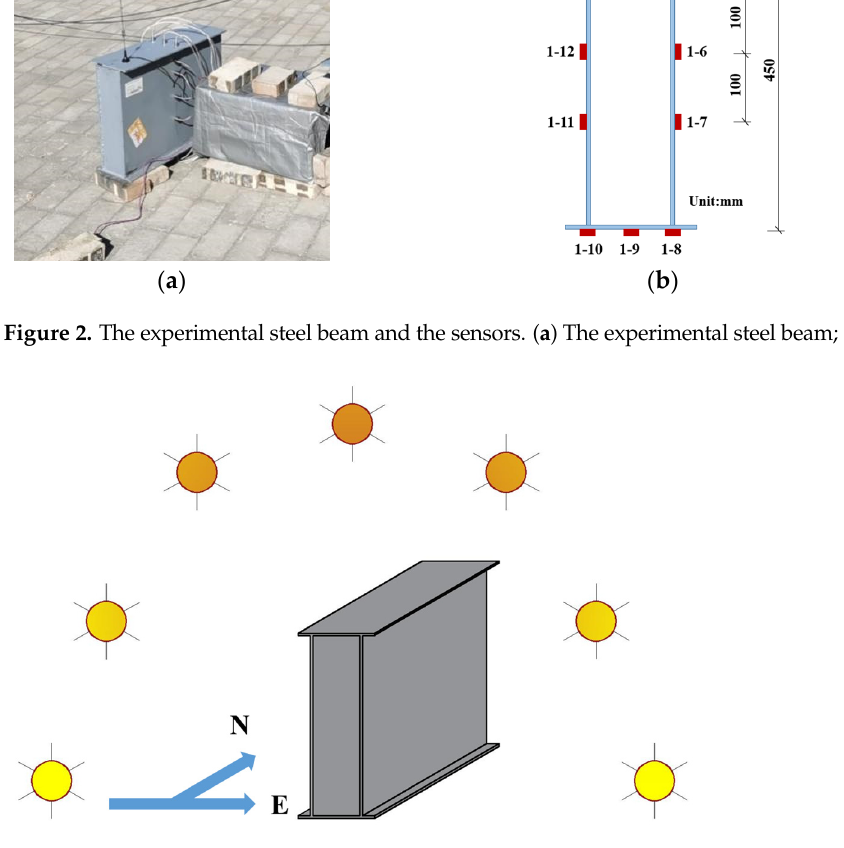
Figure 3. Orientation of the test beam segment.